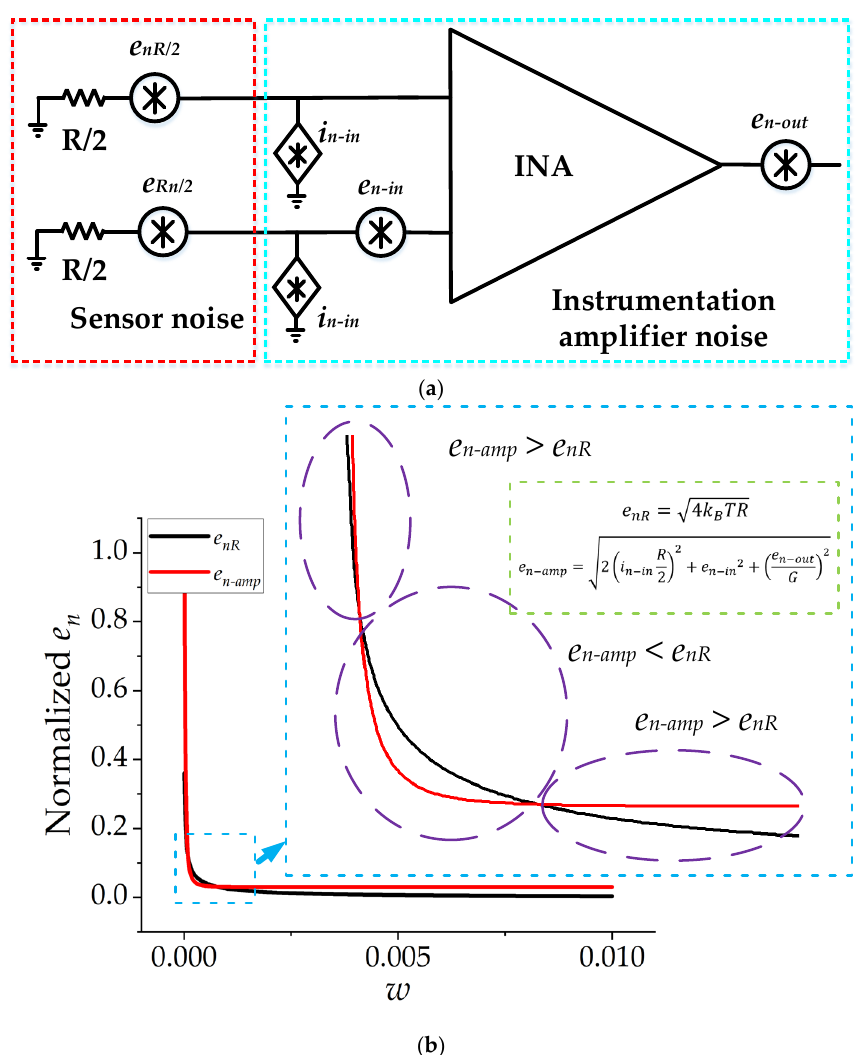
Figure 6. ( a ) The noise model of the µSCM integrated with an instrumentation amplifier at a low- frequency range. ( b ) The normalized noise power spectral density of sensor noise and instrumentation amplifier (INA188) noise as a function of w ( D o = 1 mm, d i = 0.2, s = 0.001).